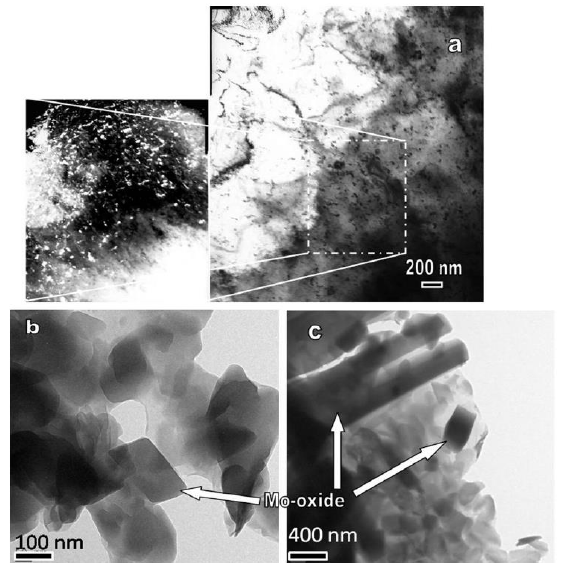
Figure 8. TEM micrographs showing ( a ) the presence of the precipitates within the matrix. Inset shows the magnified view; ( b ) Magnified view showing the presence of Mo-oxide phase in the weld region. ( c ) The presence of needle-shaped long oxides may be noticed [5].